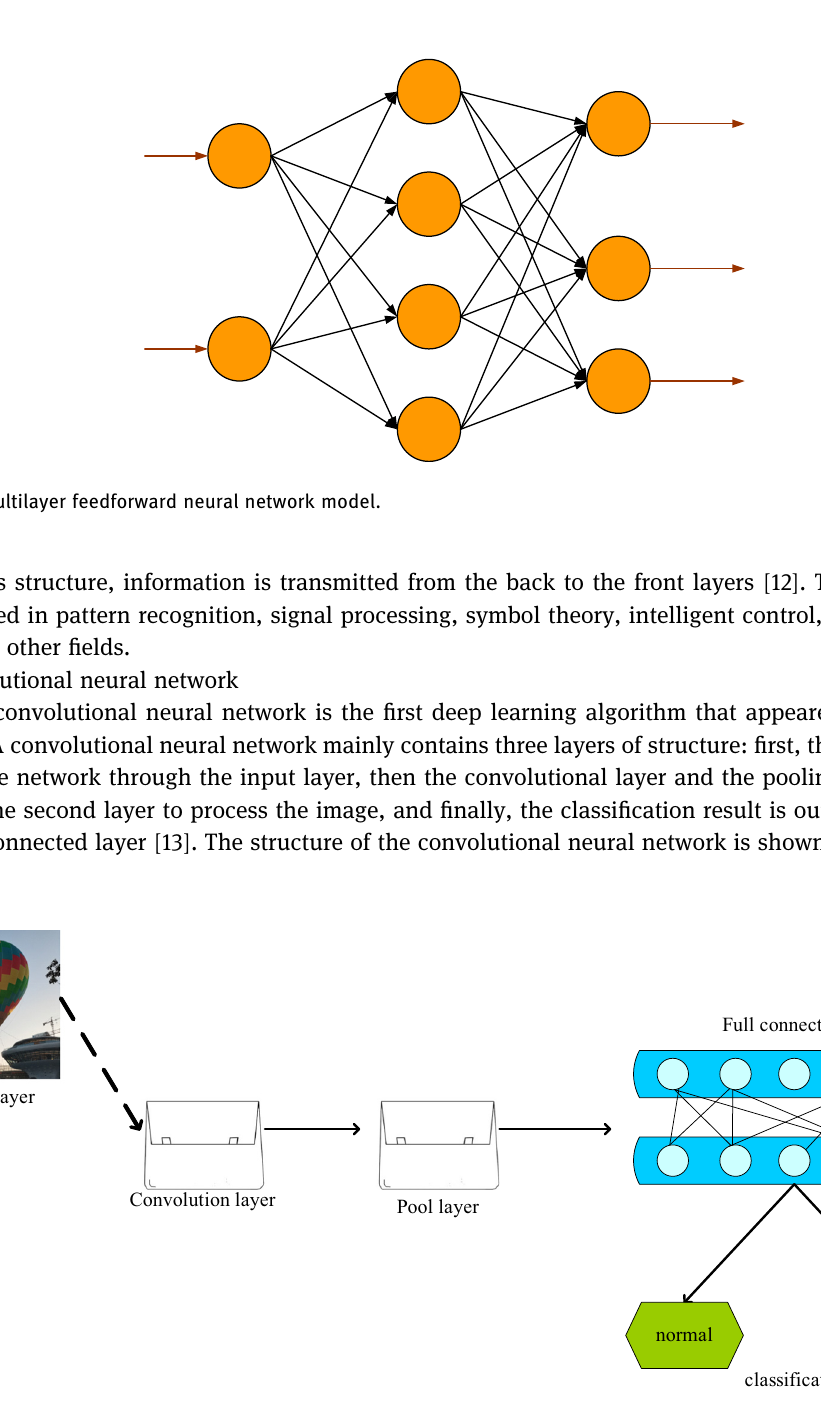
Figure 4: Schematic diagram of convolutional neural network